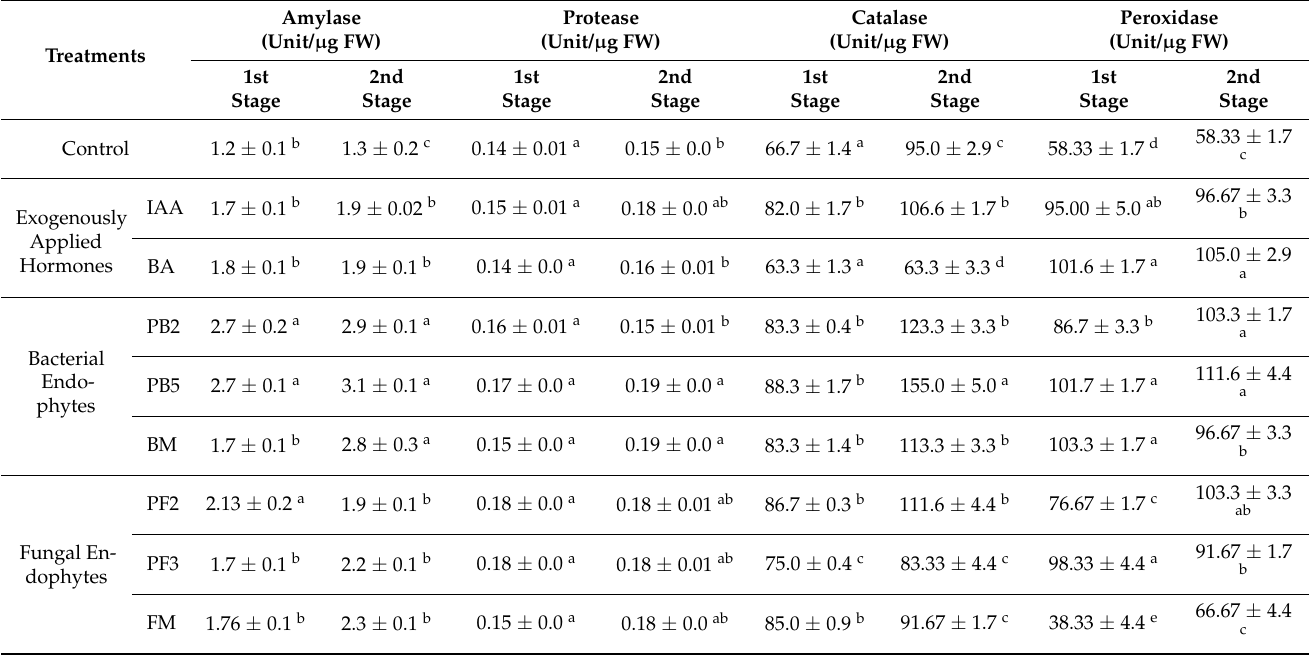
Table 5. Effect of foliar spraying of exogenously applied hormones and microbial endophyte metabolites on amylase, protease, catalase, and peroxidase of common bean